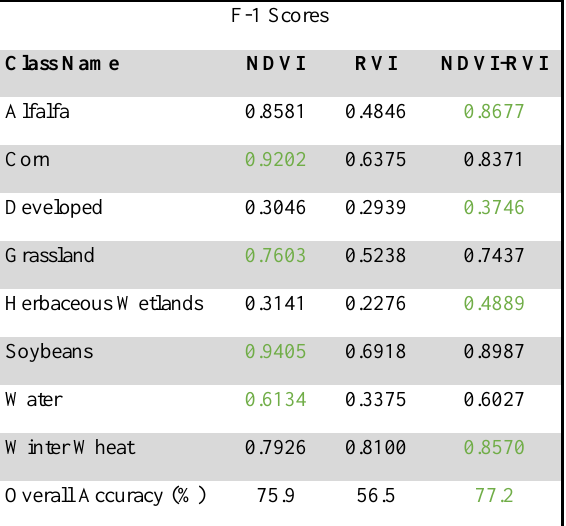
Table 1 . The accuracy results of the classifications